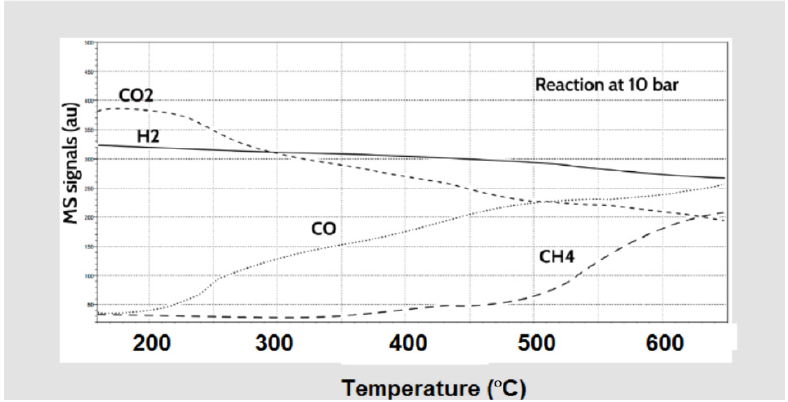
Figure 5. Spectrum of signals at 10 bar.